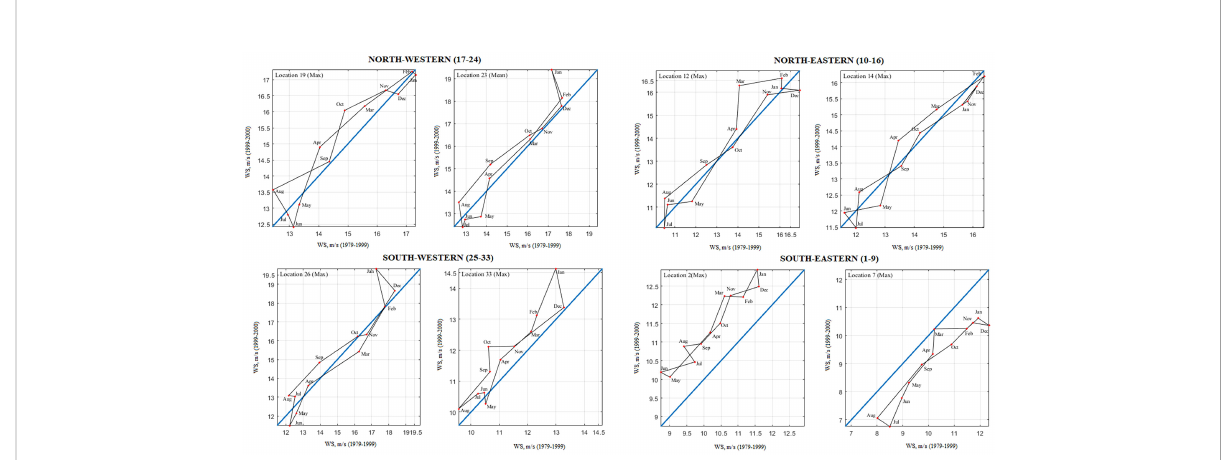
FIGURE 9 IPTA results for monthly maximum WSs during 42 years between 1979 and